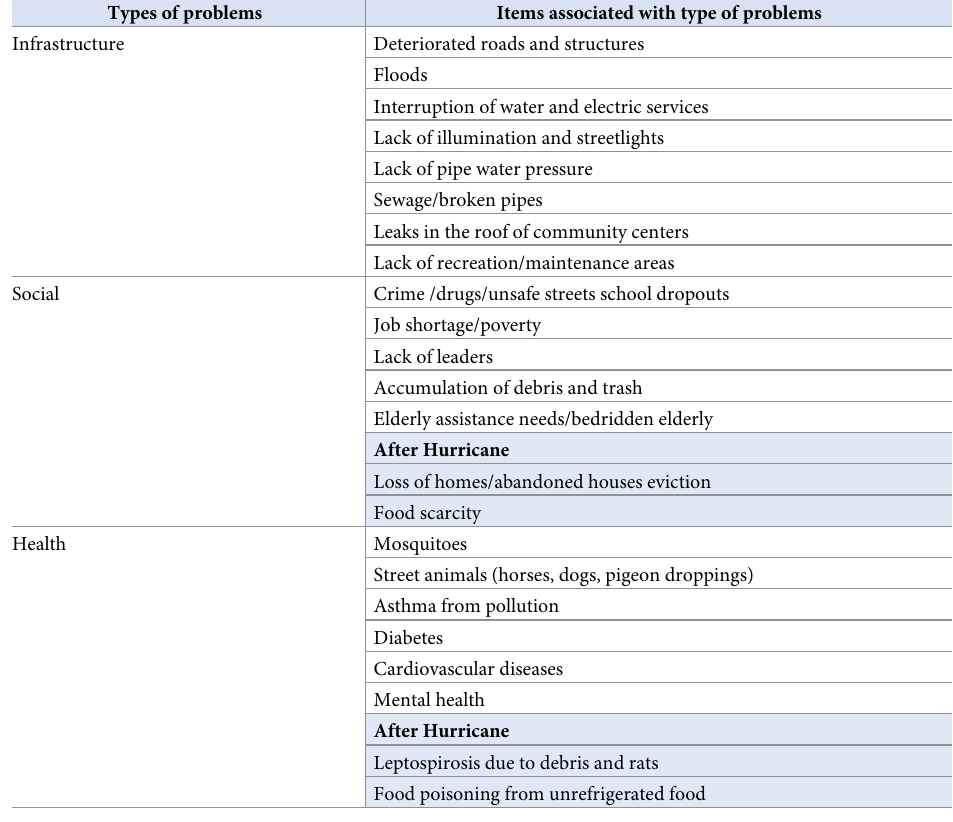
Table 1. Important problems in the communities mentioned by participants of the focus groups discussions and the in-depth